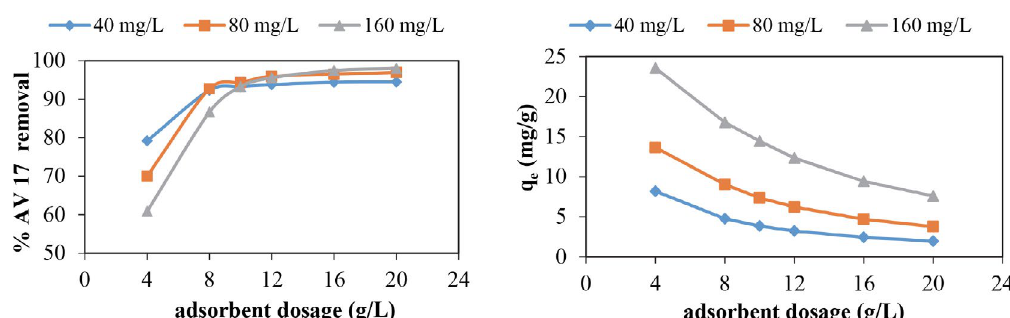
Fig. 9. Impact of adsorbent dosage on the adsorption of AV 17 by